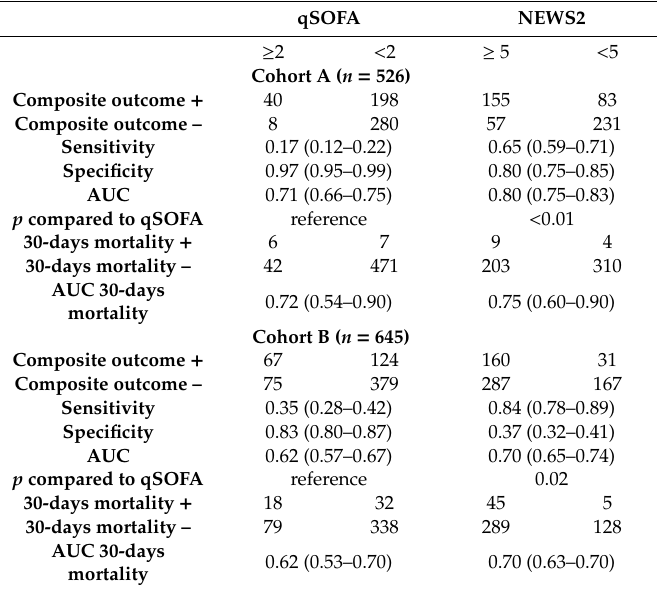
Table 3. Accuracy of risk stratification